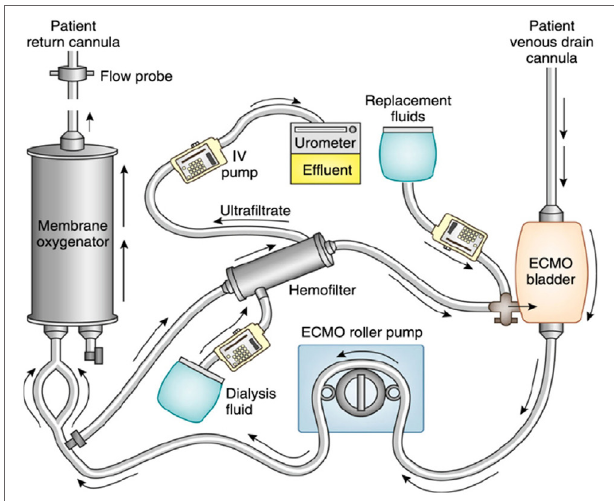
FigURe 1 | Renal support therapy using an in-line hemofilter with extracorporeal membrane oxygenation (ECMO). Blood from the ECMO circuit is shunted through an in-line hemofilter. The volume of fluid removed by the hemofilter, the ultrafiltrate, can be controlled using an intravenous pump. A filter replacement fluid or dialysis fluid can be used for additional solute clearance. Reprinted with permission from Askenazi et al. (19).